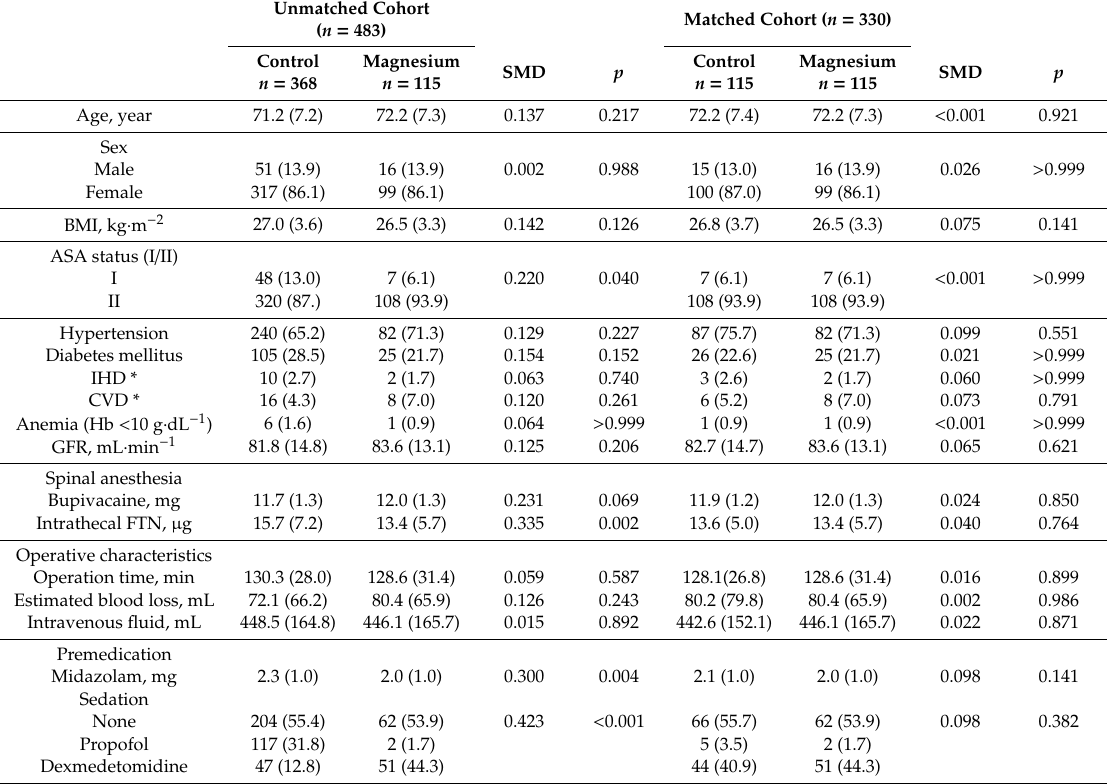
Figure 1. Flow chart of patient selection. TKA, total knee arthroplasty; ASA, American Society of Anesthesiologists; GFR, glomerular filtration rate. Table 1. Baseline characteristics before and after propensity score matching .